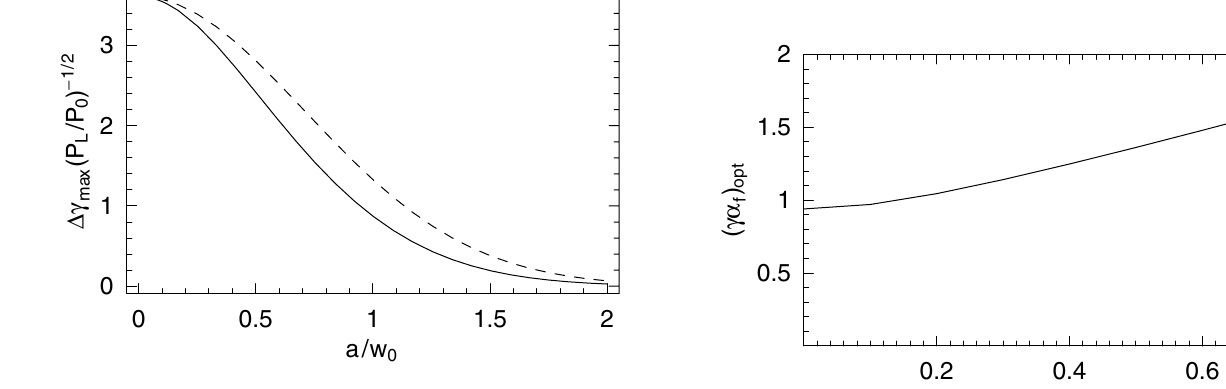
FIG. 3. The maximum energy gain of two crossed laser beams evaluated at the optimal tilt angle from Eq. (37) (solid line), and compared with the approximate Eq. (39) (dashed line).